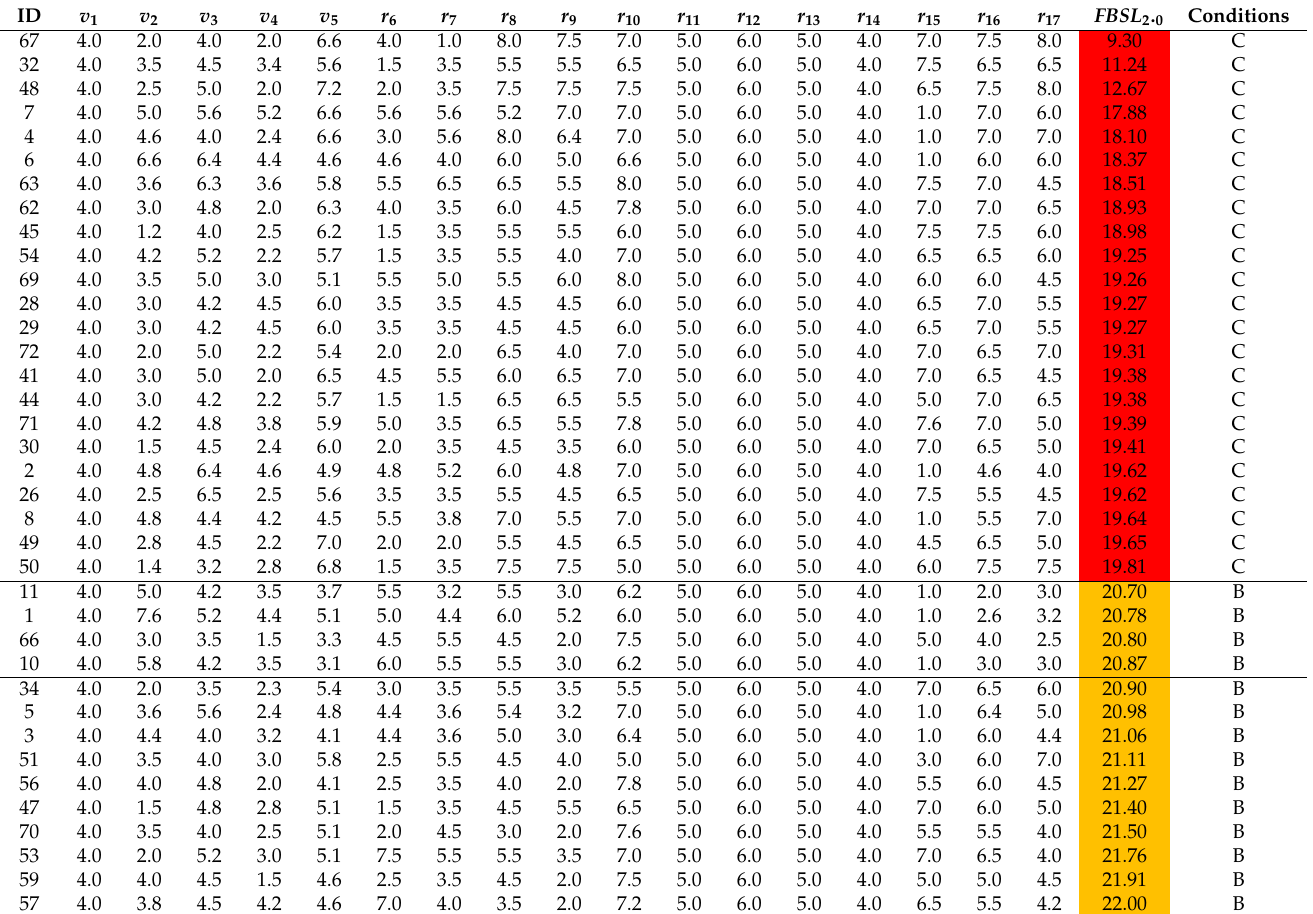
Table 7. Functional condition of the 72 timber buildings